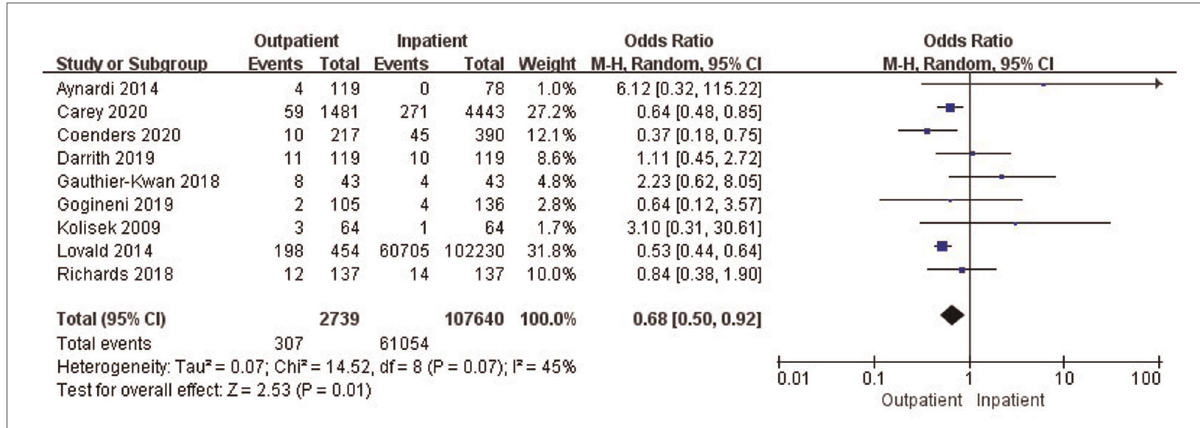
FIGURE 8 Comparison of 90-day total complications between outpatient and inpatient TJA.